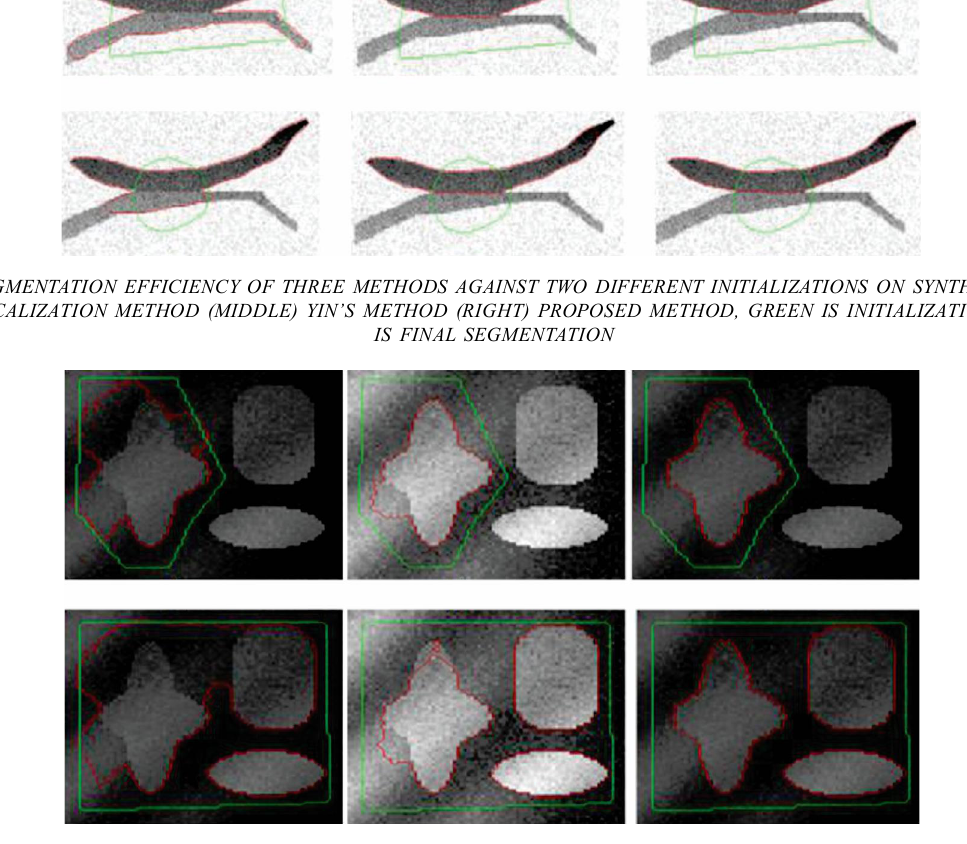
FIG. 3. SEGMENTATION EFFICIENCY OF THREE METHODS AGAINST TWO DIFFERENT INITIALIZATIONS ON SYNTHETIC MULTI- OBJECT IMAGE (LEFT) LOCALIZATION METHOD (MIDDLE) YIN’S METHOD (RIGHT) PROPOSED METHOD, GREEN IS INITIALIZATION AND RED IS FINAL